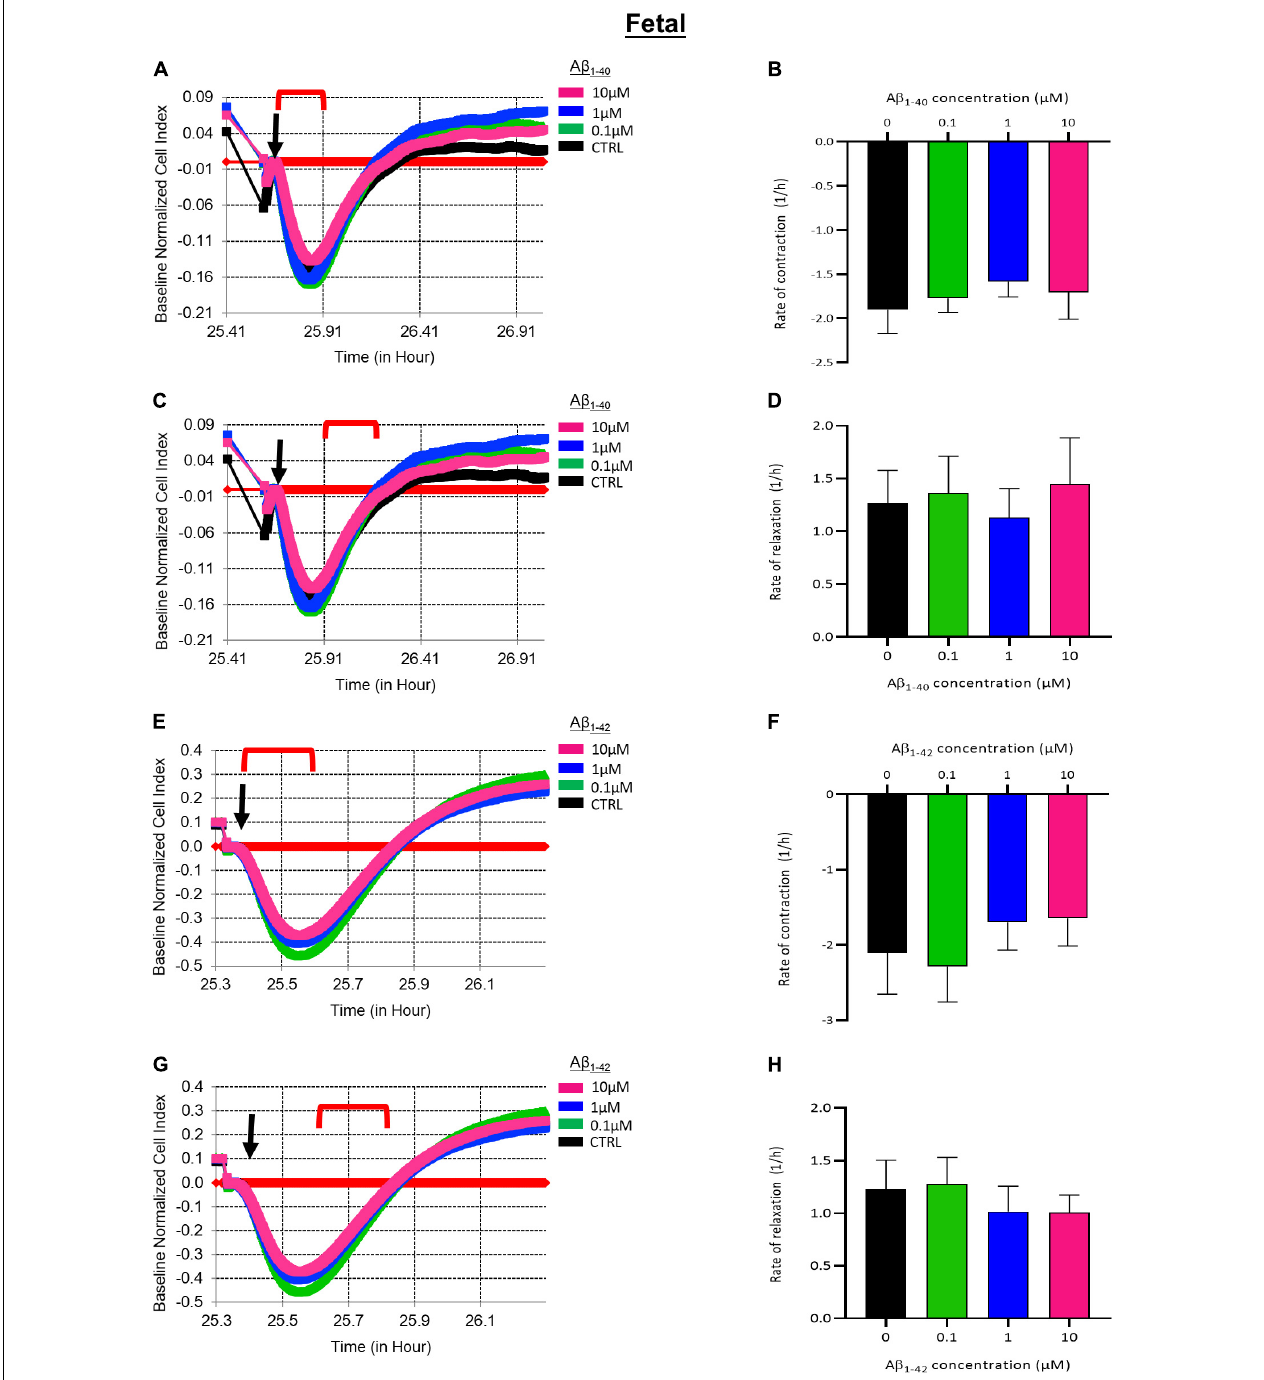
FIGURE 6 | (A) Representative electrical impedance measurements of the contractile response of fetal human brain vascular pericytes (fHBVP) to EDN1 (100 nM) after 1 h incubation with A β 1 − 40 ( n = 1). (B) There was no significant difference between the rate of contraction of EDN1-treated cells following pre-exposure to A β 1 − 40 ( n = 7). (C) Representative electrical impedance measurements of the relaxation response of fHBVP following contraction ( n = 1). (D) There was also no significant difference between the rate of subsequent relaxation EDN1-treated cells following pre-exposure to A β 1 − 40 ( n = 7). (E) Representative electrical impedance measurements of the contractile response of these fHBVP to EDN1 (100 nM) after 1 h treatment with A β 1 − 42 ( n = 1). (F) The differences in the rate of contraction between EDN1-treated cells following pre-exposure to A β 1 − 42 were not statistically significant ( n = 7). (G) Representative electrical impedance measurements of the relaxation response of fHBVP following contraction ( n = 1). (H) There was also no significant difference in rate of subsequent relaxation ( n = 7). The timeframe referred to in each graph is indicated by the red bracket. Arrows indicate the timepoint of EDN1 addition. The bars represent the mean values and SEM.